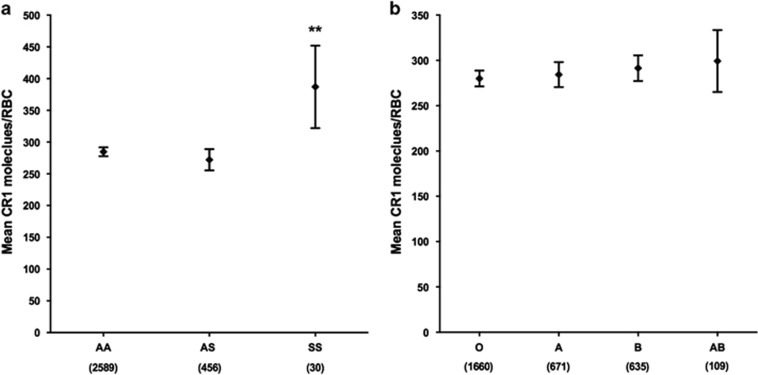
RBC CR1 level increases with homozygous HbS (HbSS) but is not affected by sickle cell trait (HbAS) or ABO blood group. (a) RBC CR1 level by HbS genotype. (b) RBC CR1 level by ABO blood group. Differences in RBC CR1 level were examined in a total of 3075 individuals by multivariate regression analysis with adjustment for age, α+thalassaemia, Sl and McC genotypes. The normal globin genotype (HbAA) and blood group O were used as the reference groups, respectively. Error bars represent 95% confidence intervals of the mean RBC CR1 level. Numbers in parenthesis reflect total number of samples tested for each genotype group. Statistically significant differences in RBC CR1 level from the reference groups are asterisked, **P<0.01.